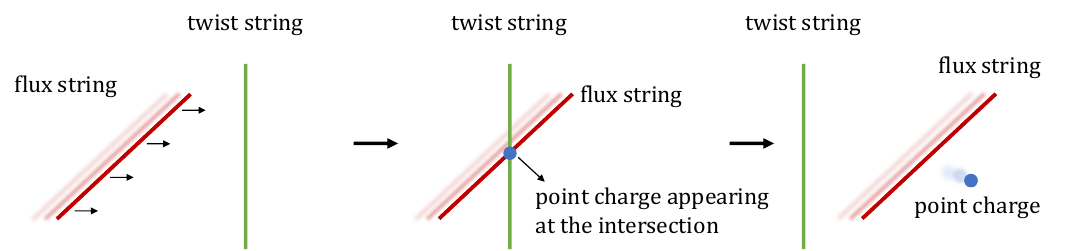
Figure 1: The vertical (green) line represents the topological twist string (codimension-2 defect), and the horizontal (red) line is the flux string. When the flux string is moved across the twist string, a point charge appears from their inter- section.